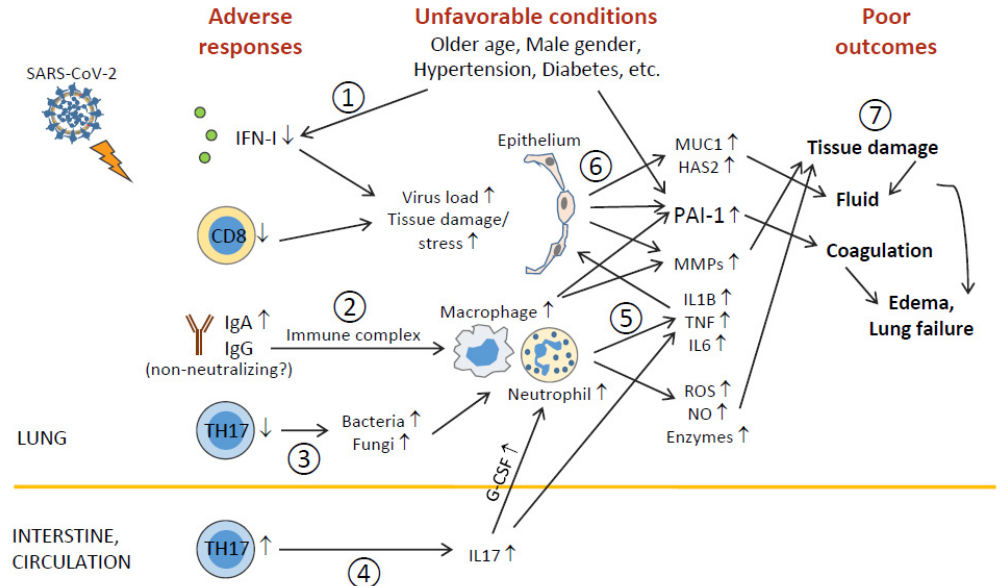
Figure 3. Outline of unfavorable conditions and deleterious pulmonary responses. ( 1 ) Older age, male gender, underlying conditions (such as hypertension, diabetes, etc.), and unknown factors (including genetic background) impair antiviral immunity (including IFN-I deficiency and decreased CD8 + T), leading to higher virus loads and tissue damage/stress. ( 2 ) Elevation of humoral responses results in massive immune complexes that activate macrophages and neutrophils. ( 3 ) Decreased TH17 cell responses cause overgrowth of commensal bacteria and fungi, which further activate macrophages and neutrophils. ( 4 ) TH17 hyperactivation and/or expansion (in the intestine?) cause high levels of serum IL17, which induces G-CSF expression and, in turn, promotes neutrophilia. ( 5 ) Hyperactivated macrophages and neutrophils release immense amounts of proinflammatory cytokines, leading to cytokine release syndrome and subsequent ARDS, as well as tissue-destructive products, such as ROS, NO, MMPs, and other enzymes. ( 6 ) During ARDS, proinflammatory cytokines act on epithelial cells and induce MMPs, mucins, hyaluronic acids, antimicrobial peptides, and PAI-1 (unfavorable conditions also elevate PAI-1 expression). ( 7 ) ROS, NO, MMPs, and other enzymes cause epithelial and endothelial leakage, leading to tissue fluid/plasma accumulation in alveolar spaces. Mucins, hyaluronic acids, and antimicrobial peptides concentrate alveolar fluids and thicken mucosal lining, resulting in edema and even lung failure. Heightened PAI-1 facilitates coagulation and strengthens edema formation (and thrombosis). ARDS also has systemic consequences causing multiorgan injury.